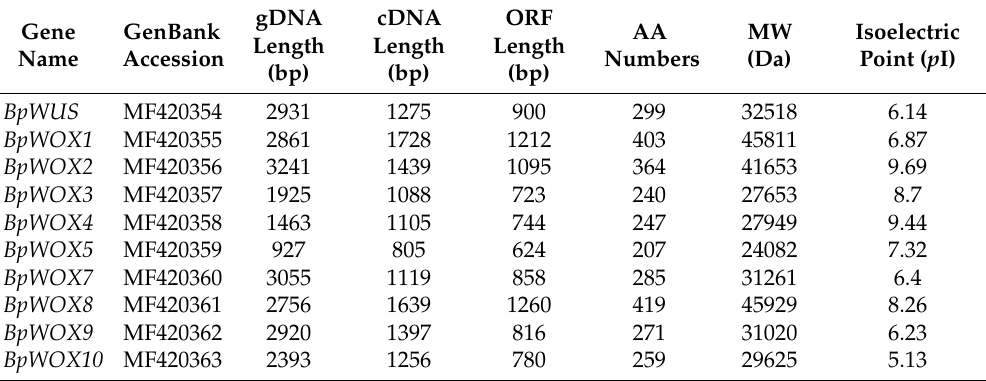
Table 1. Sequence information of BpWOX family in paper